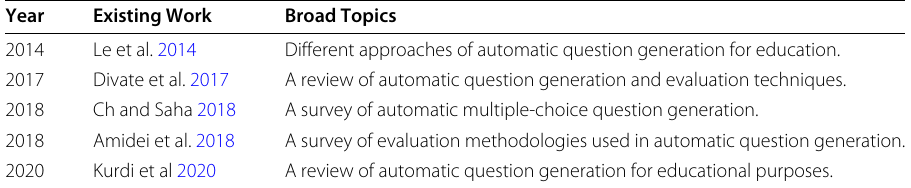
Table 1 Recent surveys on automatic question